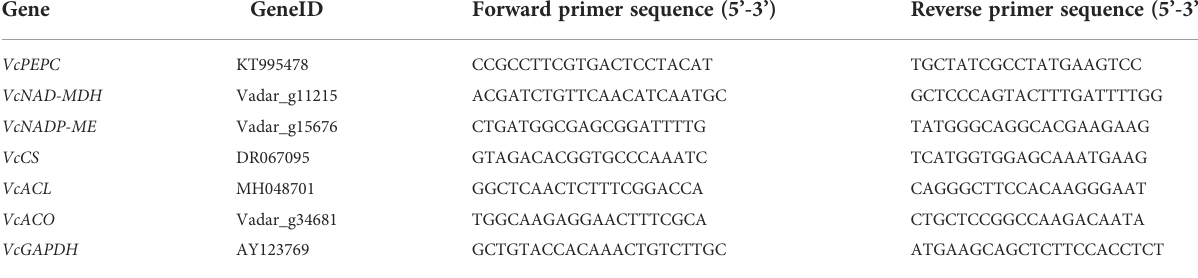
TABLE 1 The sequences of primers used for